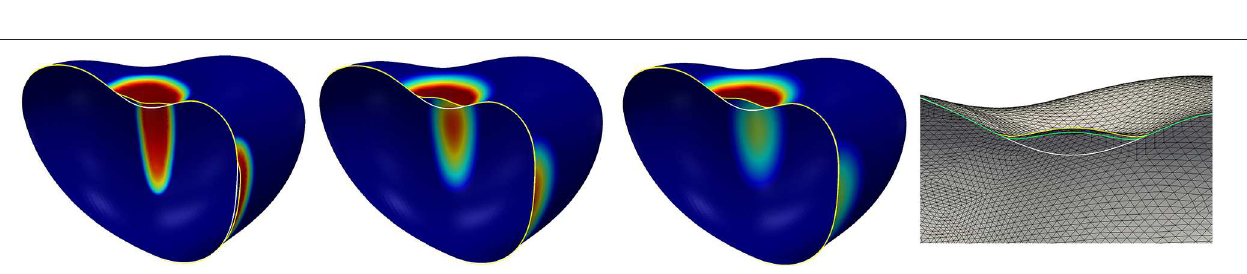
implementation of such moving boundary problems.